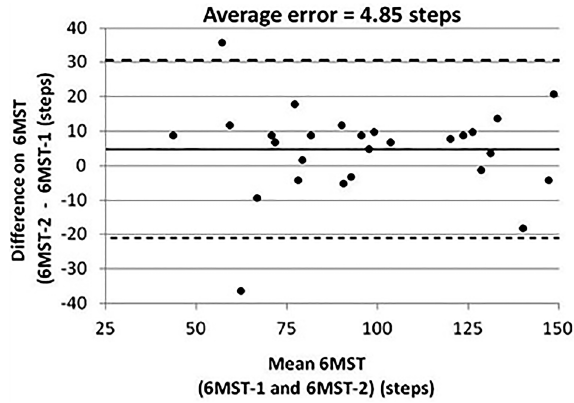
Figure 2. Bland-Altman plot for error measurement analysis between the fi rst and second six-minute step test (6MST) con- sidering as variable the number of steps.